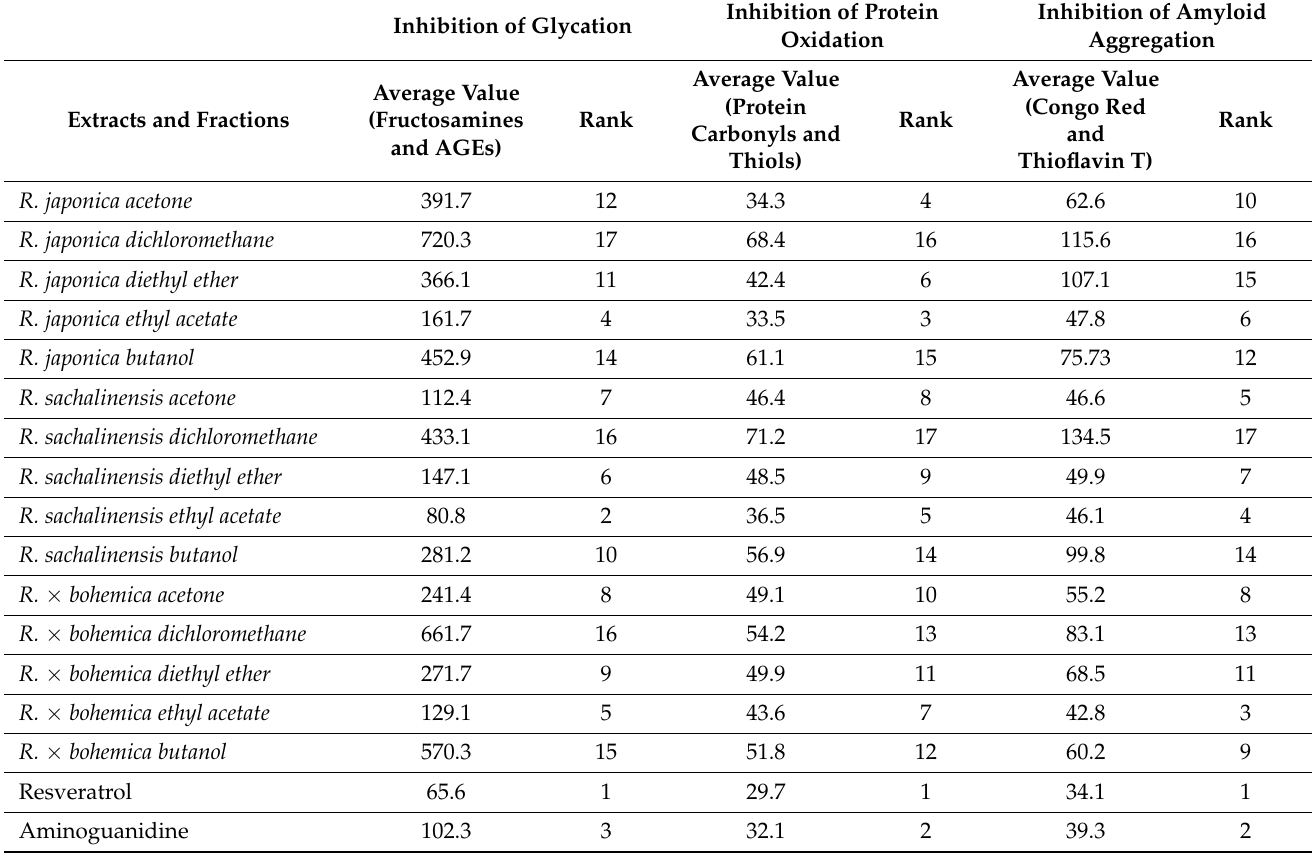
Table 1. The summary of antiglycoxidation potential for each of the analyzed plant extracts and fractions at three stages of glycooxydation and their relative ranking (for BSA).